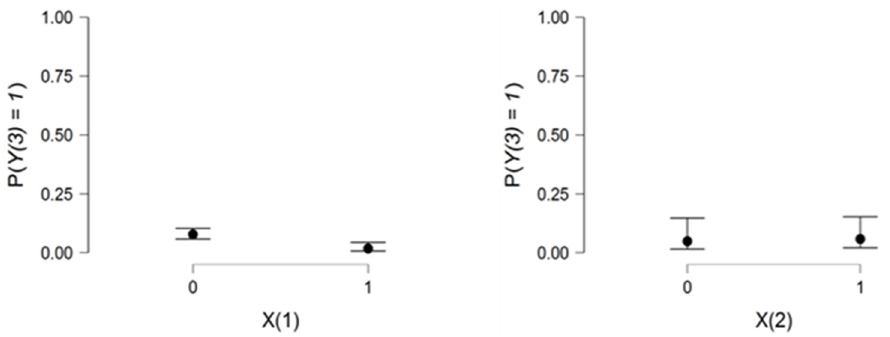
Figure 6. Relationship between the dependent variable 𝑌 (cid:2871) and the two explanatory variables 𝑋 (cid:2869) and 𝑋 (cid:2870) .